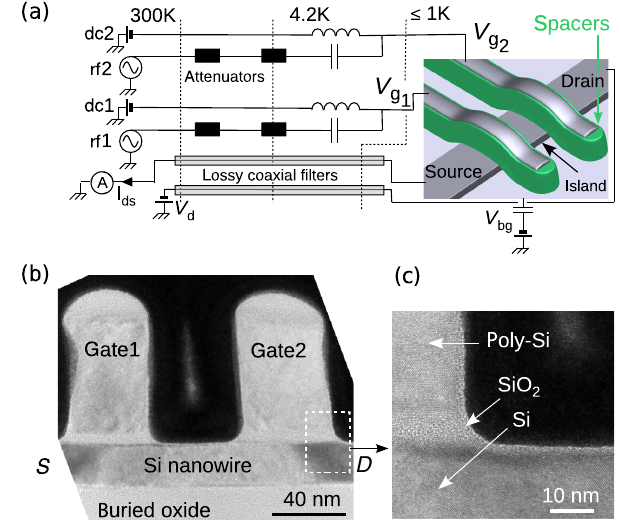
FIG. 1. (a) Schematic view of the wiring and sample layout. The single metallic island is controlled by two silicon transistors and V on which dc that are controlled by the gate voltages V g1 g2 and rf signals are applied. (b),(c) Transmission electron micro- graphs of the two-gate structure after gate etching. (Spacers as well as silicidation are not shown here.) The single-crystal . A silicon channel is isolated from the gates by 5 nm of SiO 2 is applied through the 145-nm-thick back-gate voltage V bg buried oxide of the silicon-on-insulator